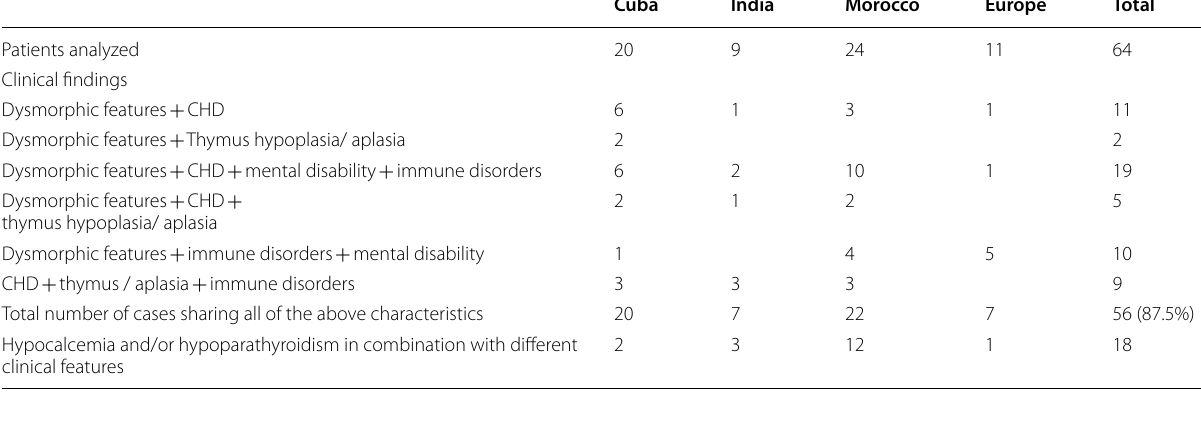
Table 5 Different combinations of clinical features that contributed to the disease molecular diagnosis. The eight prenatal cases were excluded here